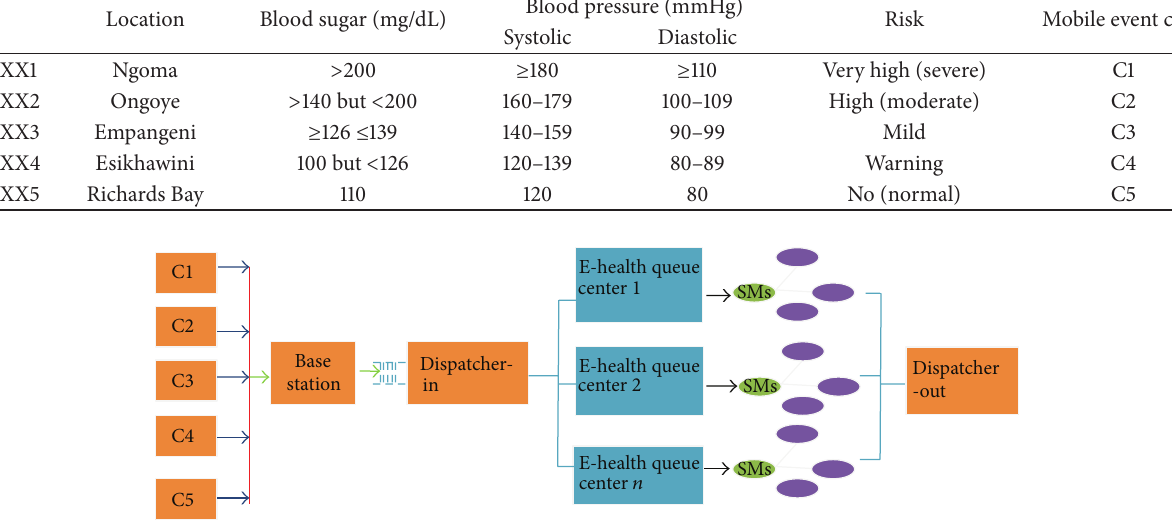
Figure 2: Proposed GUISET mobile healthcare